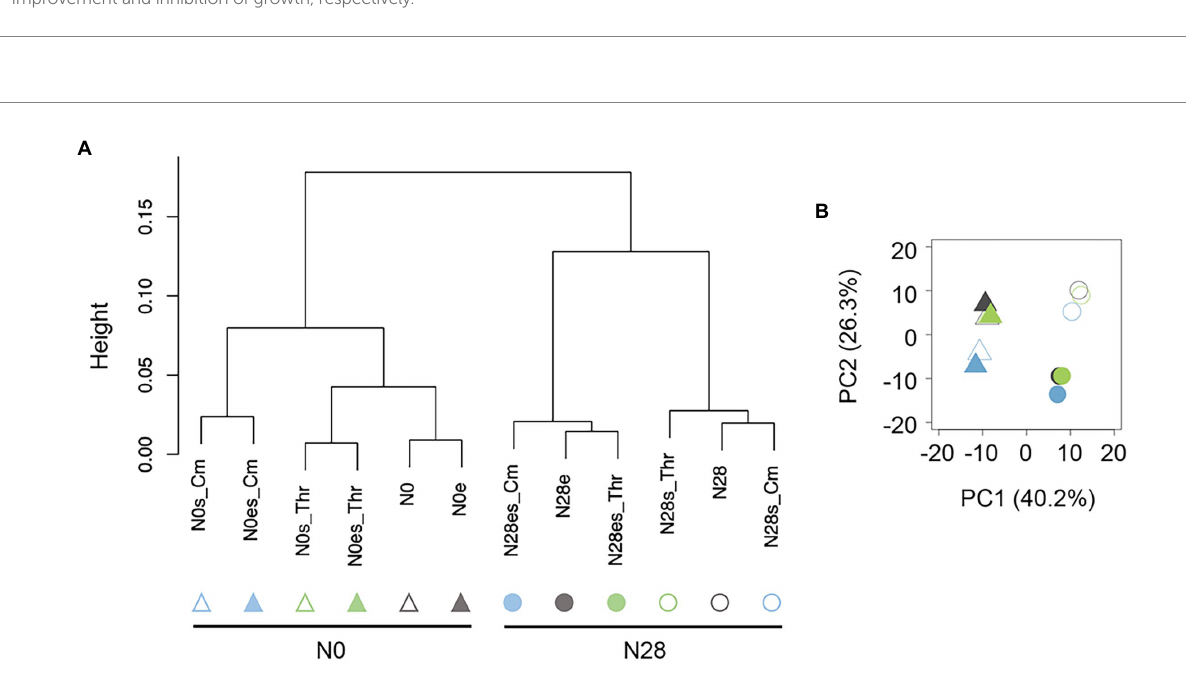
FIGURE 2 Global gene expression patterns. (A) Hierarchical clustering of gene expression. (B) Principal component analysis. Triangles and circles represent the wild-type (N0) and reduced (N28) genomes, respectively. Green and blue indicate the addition of Thr and Cm in the culture, respectively. The open and closed signals represent the ancestor and evolved genomes,